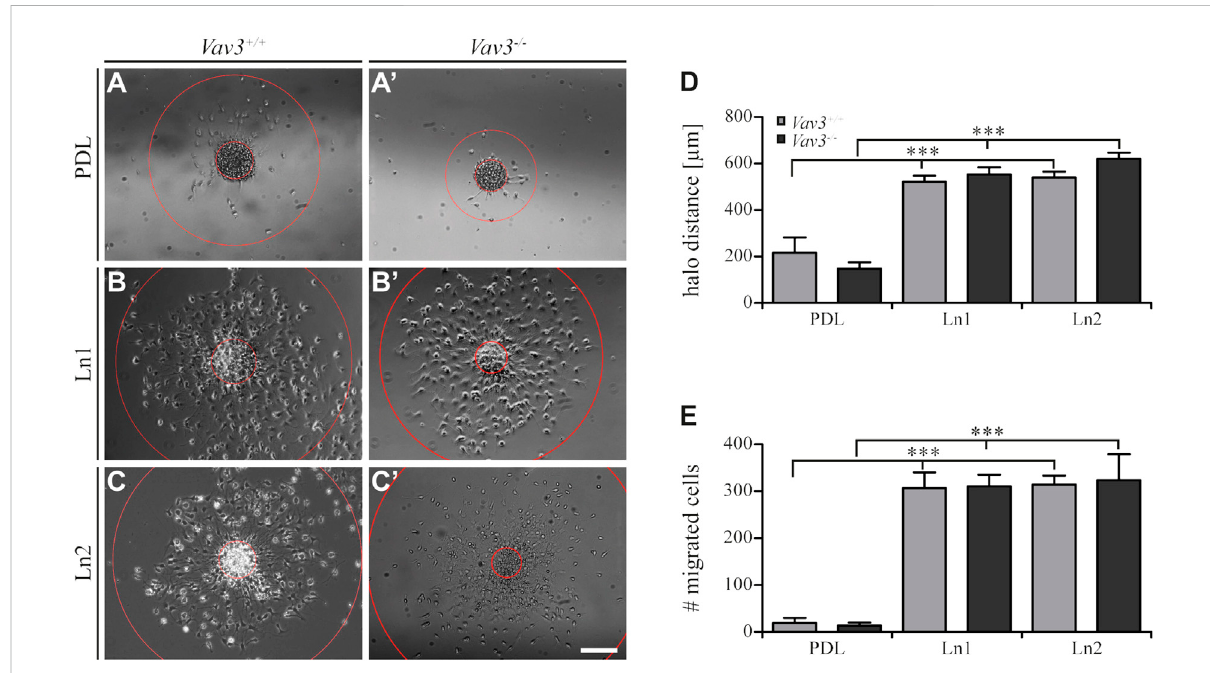
FIGURE 2 MigrationofOPCsfromoligospheres onPDLandlaminins. (A+A 9 ) Vav3-expressing( Vav3 +/+ )andVav3-de fi cient( Vav3 − / − )oligospheres onPDL after 24 h of migration. (B + B 9 ) Successful migration of OPCs from oligospheres of either genotype on laminin-1 (Ln1) after 24 h. (C + C 9 ) Migration success of OPCs from Vav3 +/+ and Vav3 − / − oligospheres on laminin-2 (Ln2) after 24 h. (D) The quanti fi cation of halo distance [in µm] revealed that OPCs on laminins covered signi fi cantly longer distances compared to the OPCs on the control substrate. (E) The quanti fi cation of total cell numbers (#) migrating on the different substrates again demonstrated a signi fi cantly higher number of moving OPCs on laminins compared to the control. Data is expressed as mean ± SEM. Student ’ s t -test was performed (*** p ≤ 0.001). N = 5, n = 5. Scale: 200